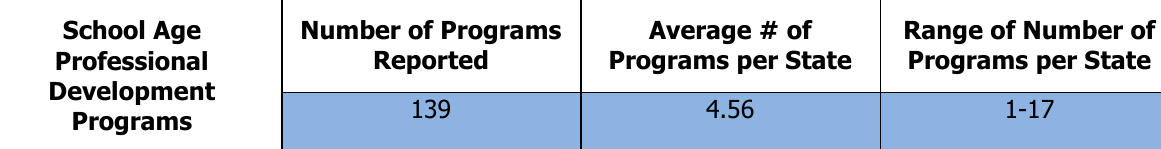
Number of School Age Professional Development Programs